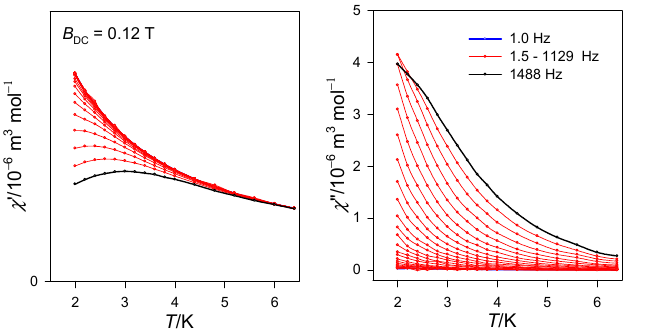
Figure 6. Temperature dependence of the AC susceptibility for 1 for a set of external fields at B DC = 0.12 T.